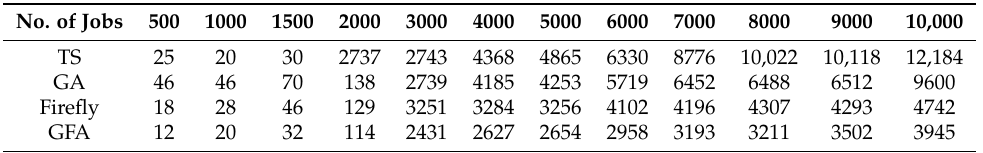
Figure 8. Execution times of the GFA Compared to Different Scheduling Methods for Different Workloads.